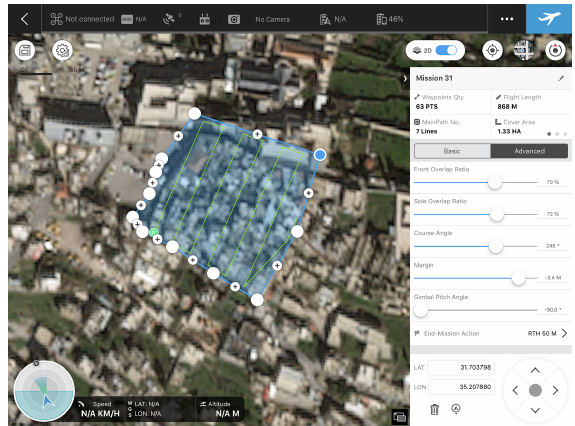
Figure 5: Editing flight mode parameters on DJI GSP.